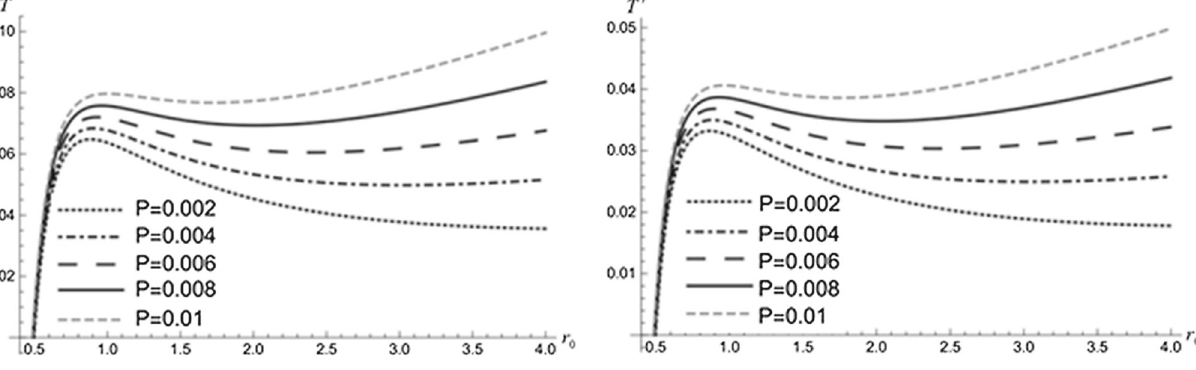
Fig. 2 The left panel: the standard temperature of the black hole vs. r 0 . The right panel: the GUP-corrected temperature vs. r 0 with β = 0 . 5. In both cases we take ¯ h = 1 , Q = 0 .